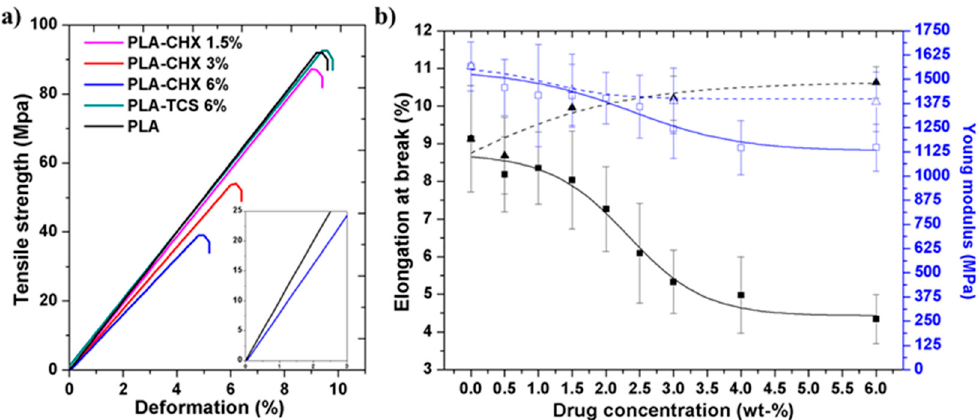
Figure 7. (a ) stress–strain plots obtained from the representative indicated samples; ( b) variation of the elongation at break (black curves) and the Young modulus (blue curves) with the TCS (dashed lines) or CHX (solid lines) load. All samples were processed under the optimized conditions of 24-300-1.2. Samples loaded with chlorhexidine followed the same trend of the GPC Table 2. Mechanical parameters extracted from stress–strain assays.